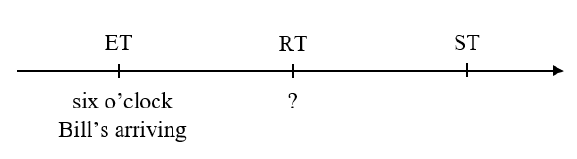
Figure 2. Past-in-the-past reading